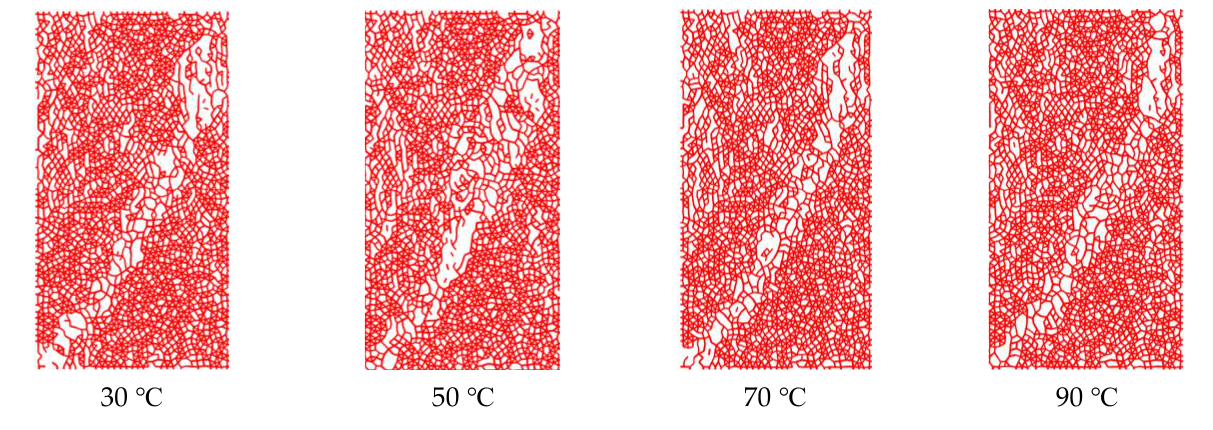
Figure 13. Contact distribution after failure.